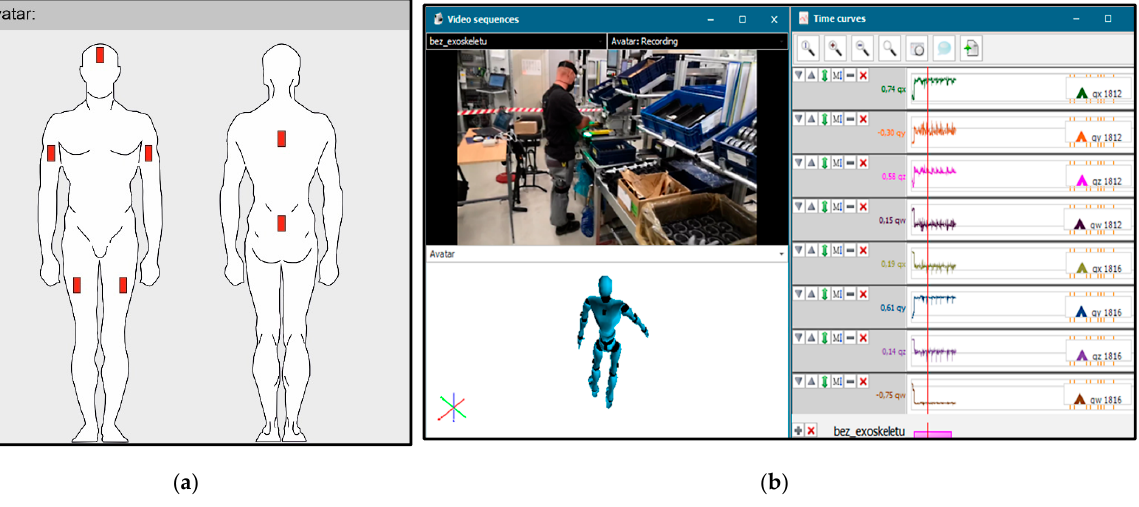
Figure 2. The setting and implementation of the measurement in the industrial workspace: ( a ) Placement of the Captiv wireless sensors on the body for experiments with and without exoskeleton; ( b ) The captured data with Captiv sensor system before their evaluation, with synchronization of data and video recording, and avatar visualization.